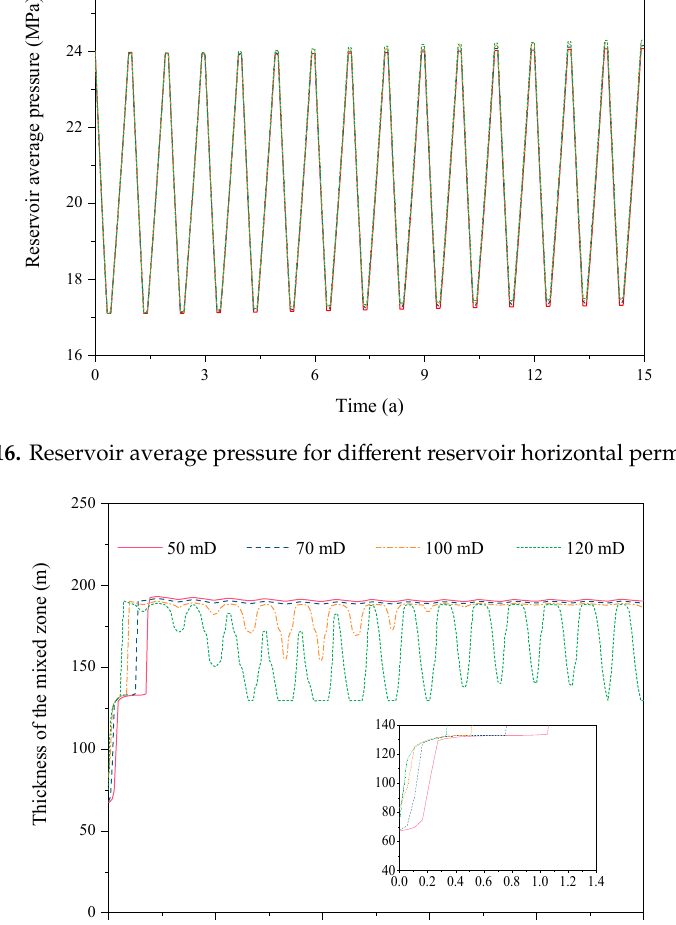
Figure 18. CO 2 concentration in the produced gas for different reservoir horizontal permeabilities.